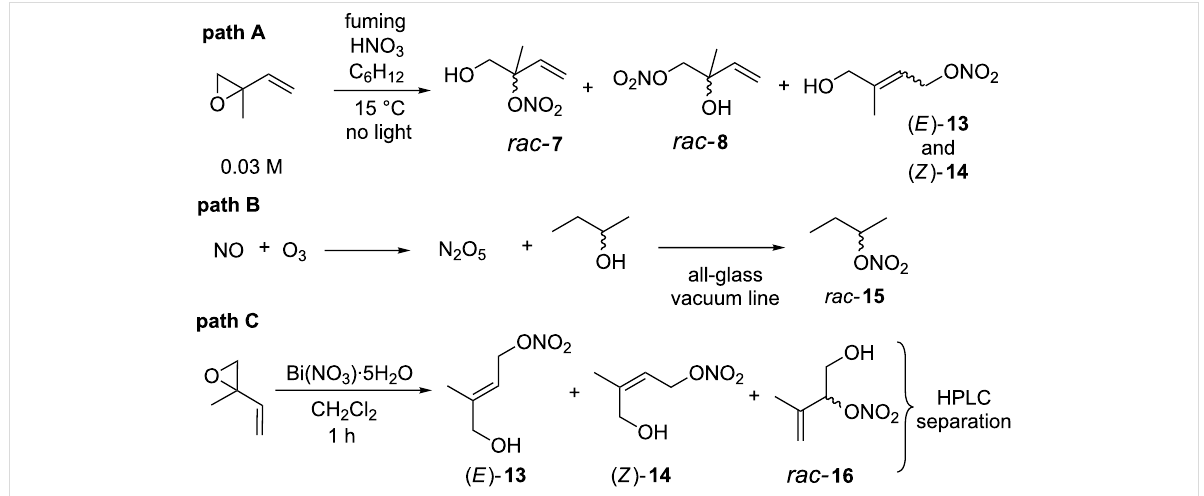
Scheme 2: Protocols for the synthesis of O -nitrated alcohols using (±)-isoprene epoxide and 2° alcohols as starting materials.